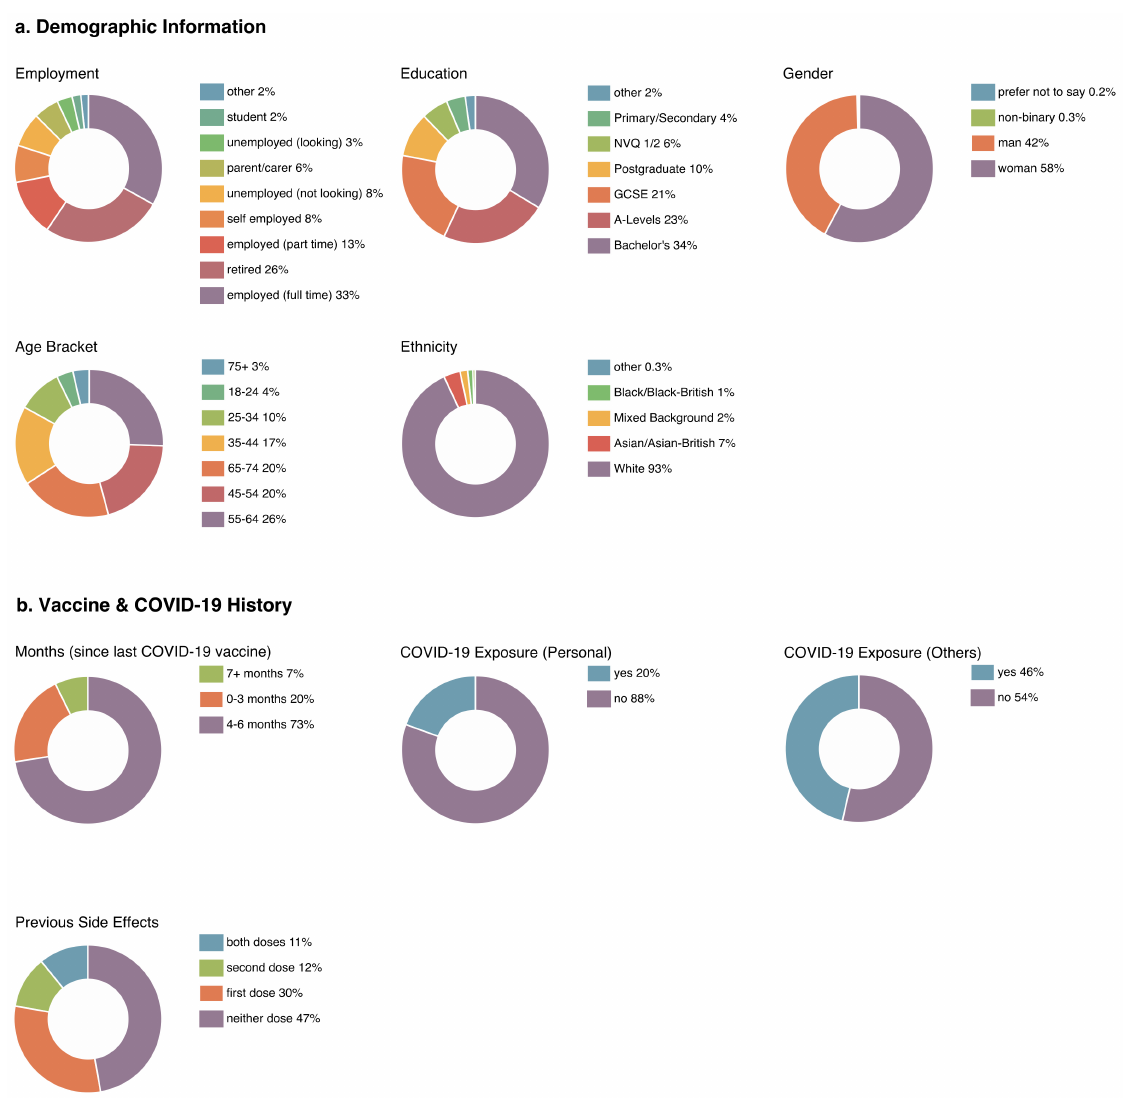
Figure 3. Descriptive statistics regarding sample demographics, as well as vaccine and COVID-19 history of the full sample ( N =